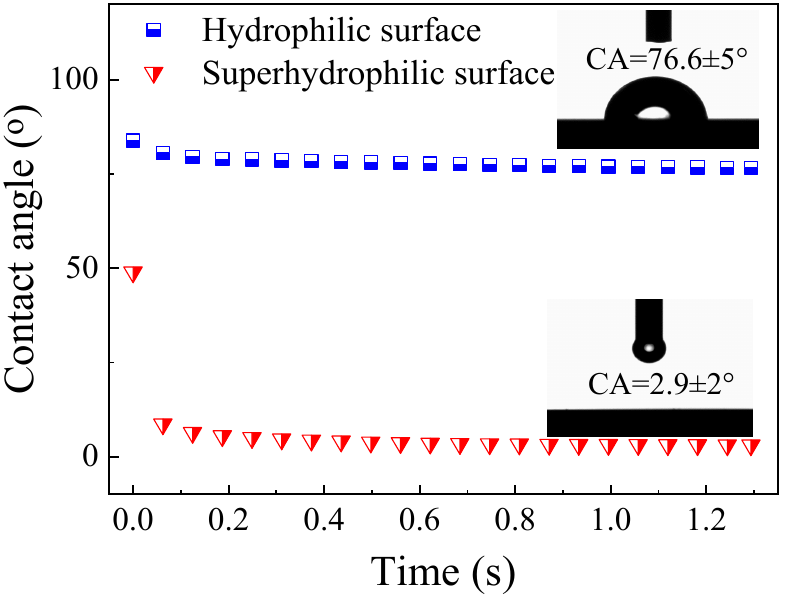
Figure 2. Contact angle measurement of hydrophilic and superhydrophilic surfaces.